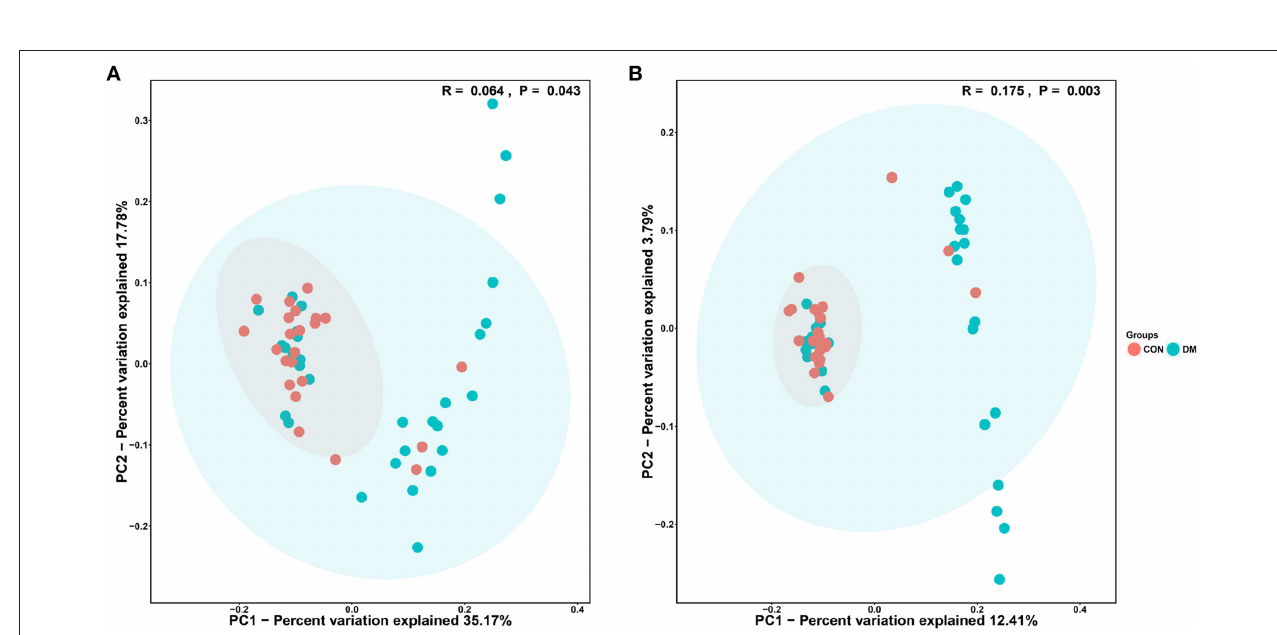
FIGURE 3 | PCoA analysis of conjunctival bacterial communities in DM patients and healthy subjects. The PCoA plot was constructed using the weighted UniFrac method. The symbols represent the bacterial communities of conjunctiva from DM patients and healthy subjects. (A) Unweighted_Unifrac_PCoA between the DM group (blue dots) and the CON group (red dots). (B) Weighted_Unifrac_PCoA between the DM group (blue dots) and the CON group (red dots).